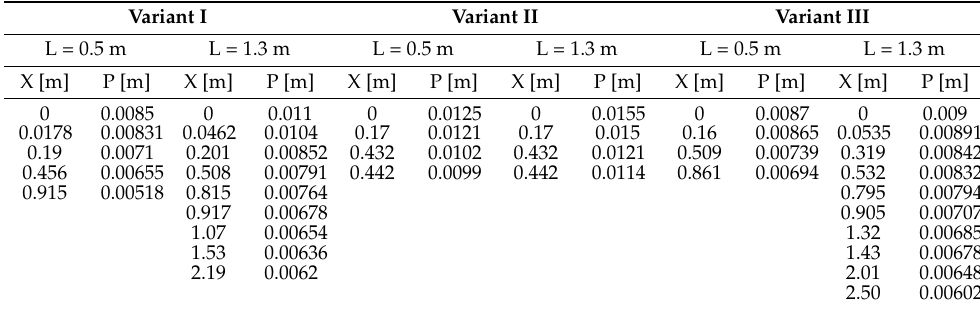
Symbols: L—distance from coal face (Figure 8), X—range of roof displacement, P—displacement.